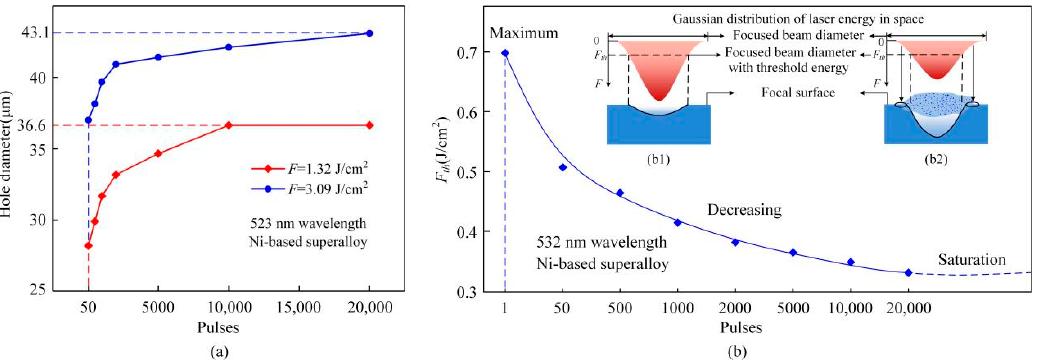
Figure 3. Hole diameter and threshold versus pulses ( a ): Hole diameter versus pulses ( b ): Threshold versus pulses ( b1 ): Idealistic relationship between bean diameter and hole diameter with single pulse ablation ( b2 ): Influencing factors of the hole diameter with pulse laser ablation.